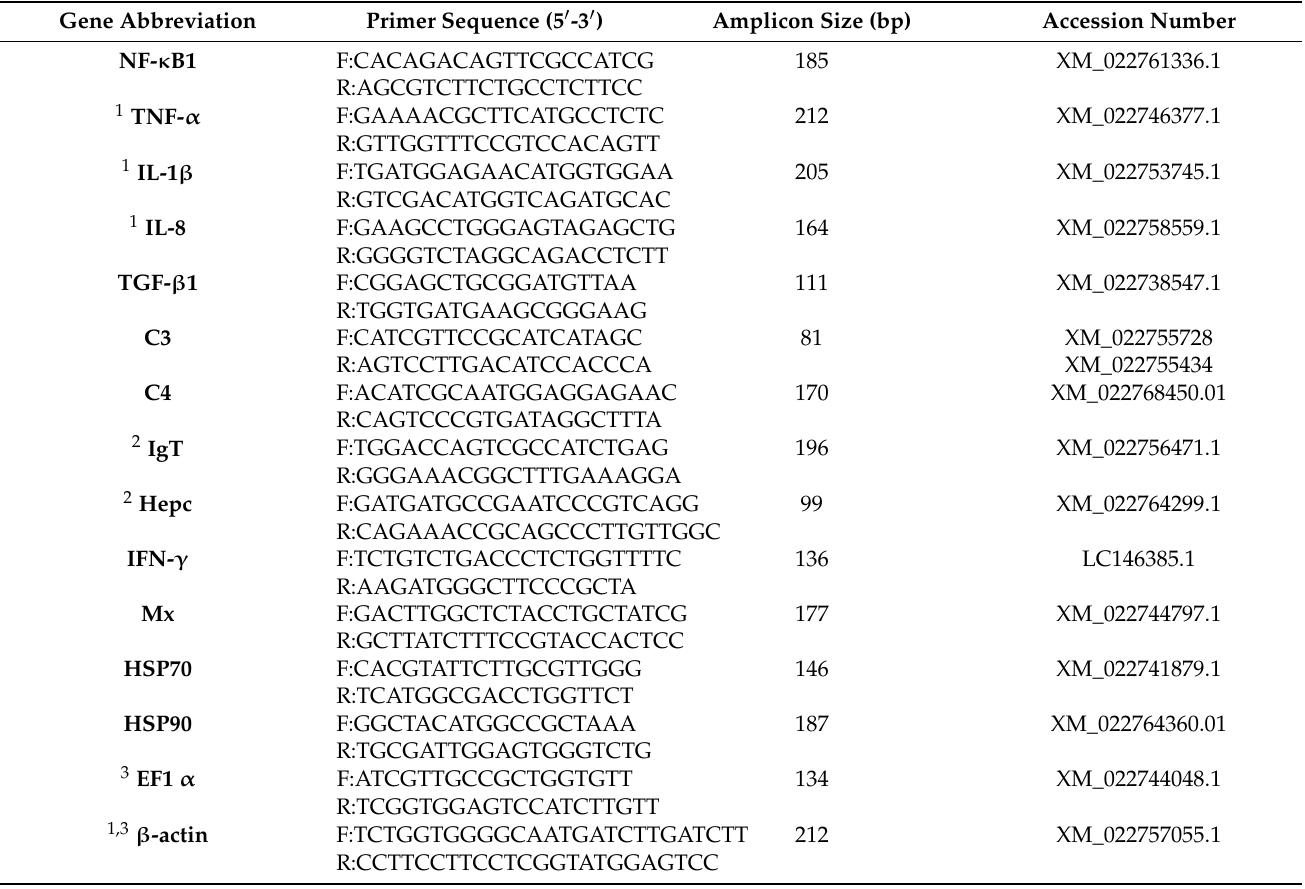
Table 2. Primer sequence